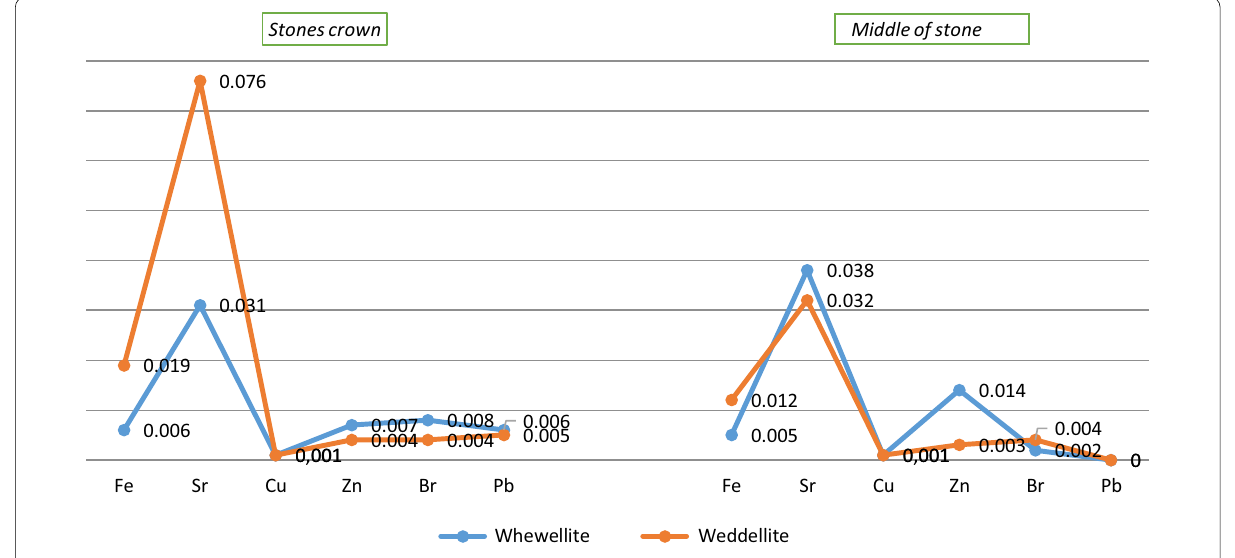
Fig. 5 Mean metal / calcium ratio as a function of crystalline phases of oxalo‑calcium